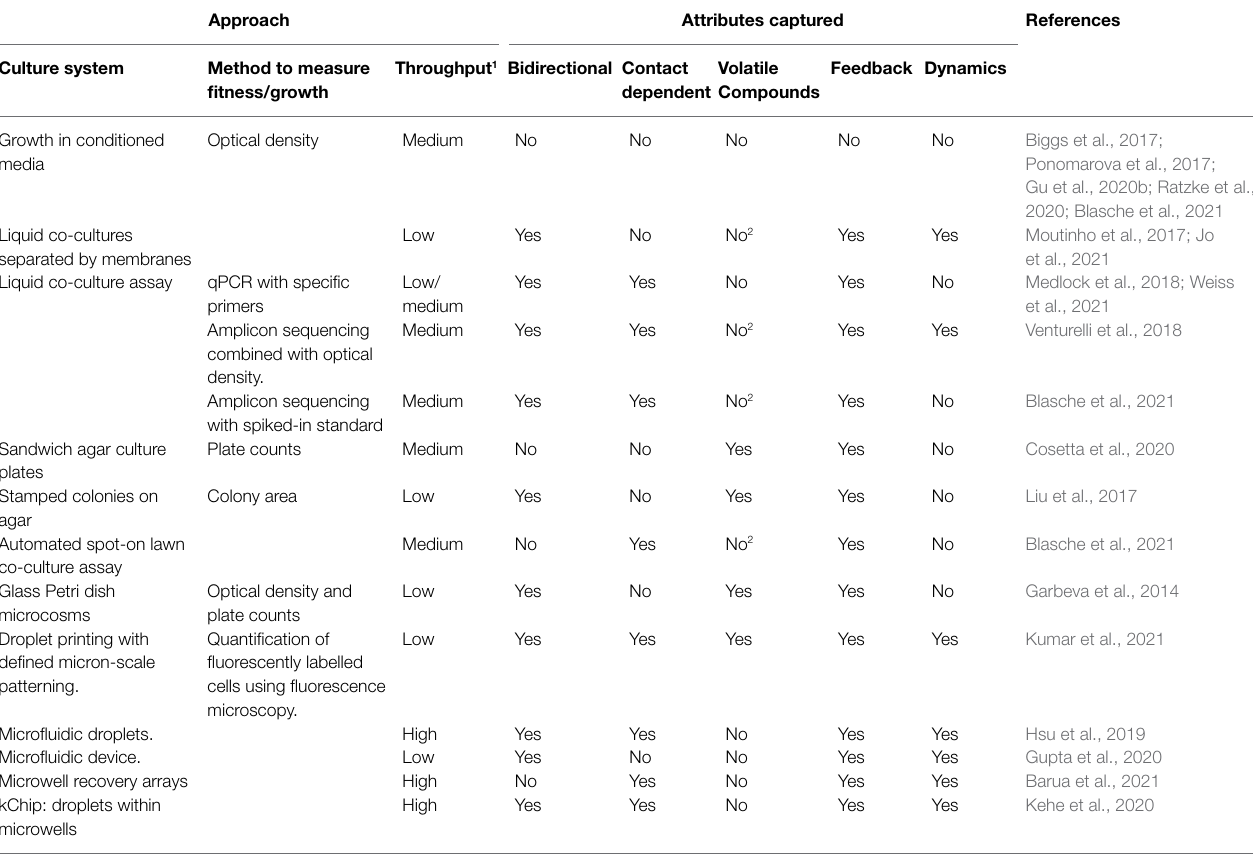
TABLE 1 | Quantitative approaches to study ecological interactions between microorganisms and their ability to capture different microbial interaction attributes.